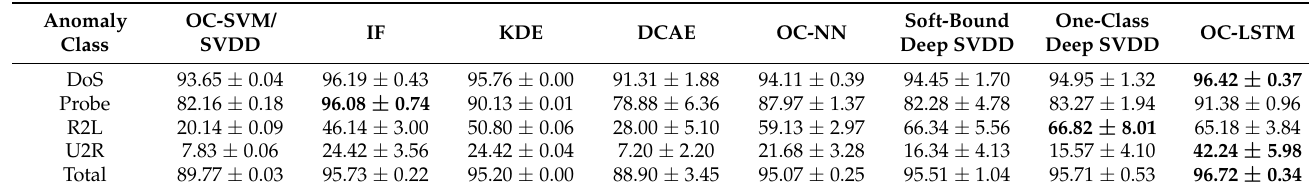
Table 3. Average AUPRC values as percentages with StdDevs per method on NSL-KDD.